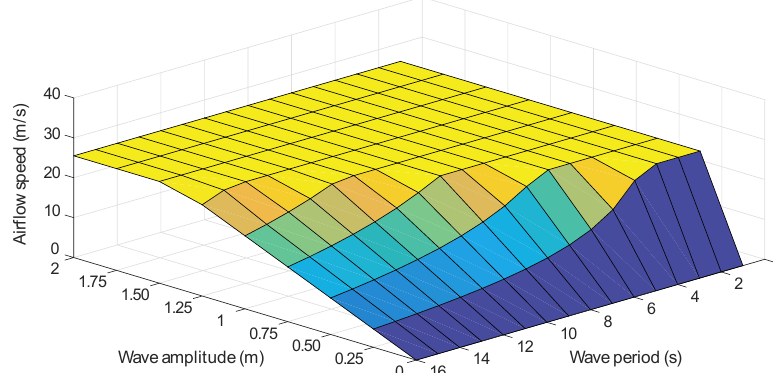
Figure 10. Desired airflow speed for different wave amplitudes and